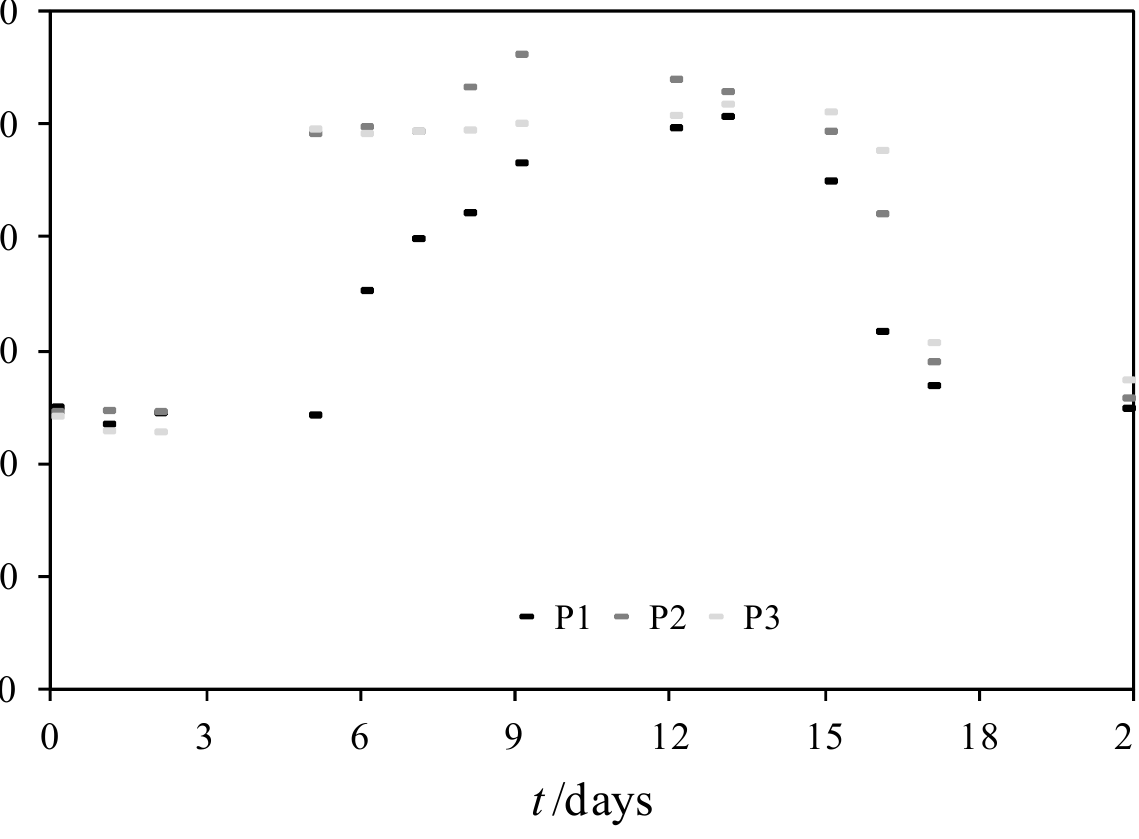
Figure 15. Temperature changes in composting mass in experiments P1, P2 and P3 for 21 days. Table 9. Physical and chemical characterization of composting mass in experiment P1, P2 and P3 at the end of composting.